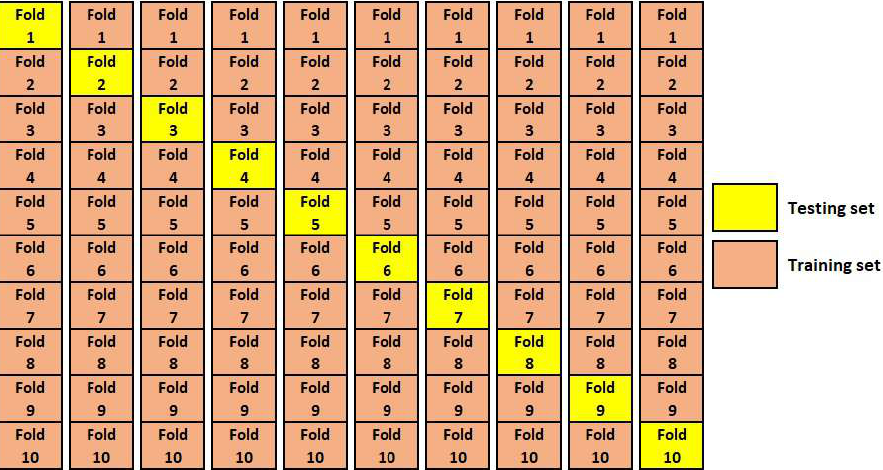
Figure 4. The ten-fold cross-validation method.